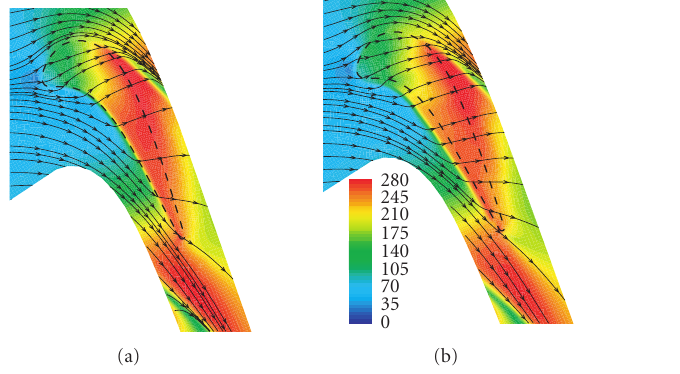
Figure 8: Streamlines superimposed on the in-plane velocity magnitude (m/s) contours at the mid-height of the tip gap (a) baseline flat tip and (b) desensitized flat tip.